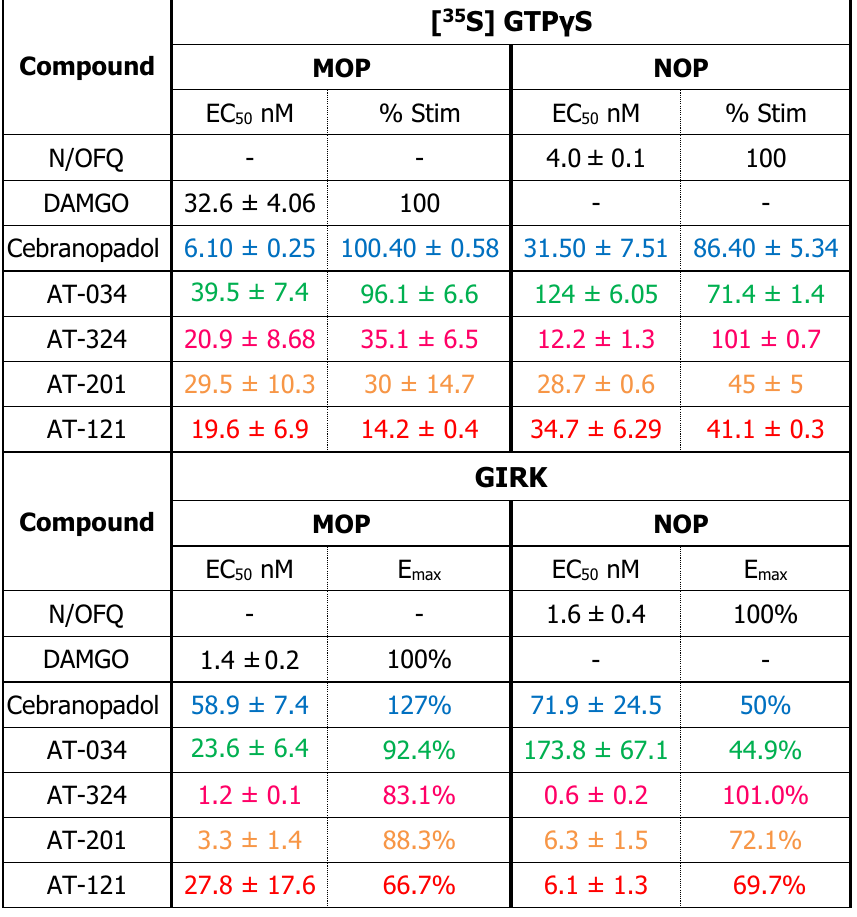
Table 2. Stimulated [ 35 S] GTPγS binding in stably transfected CHO cells and GIRK assay in stably transfected AtT-20 cells. %Stim,